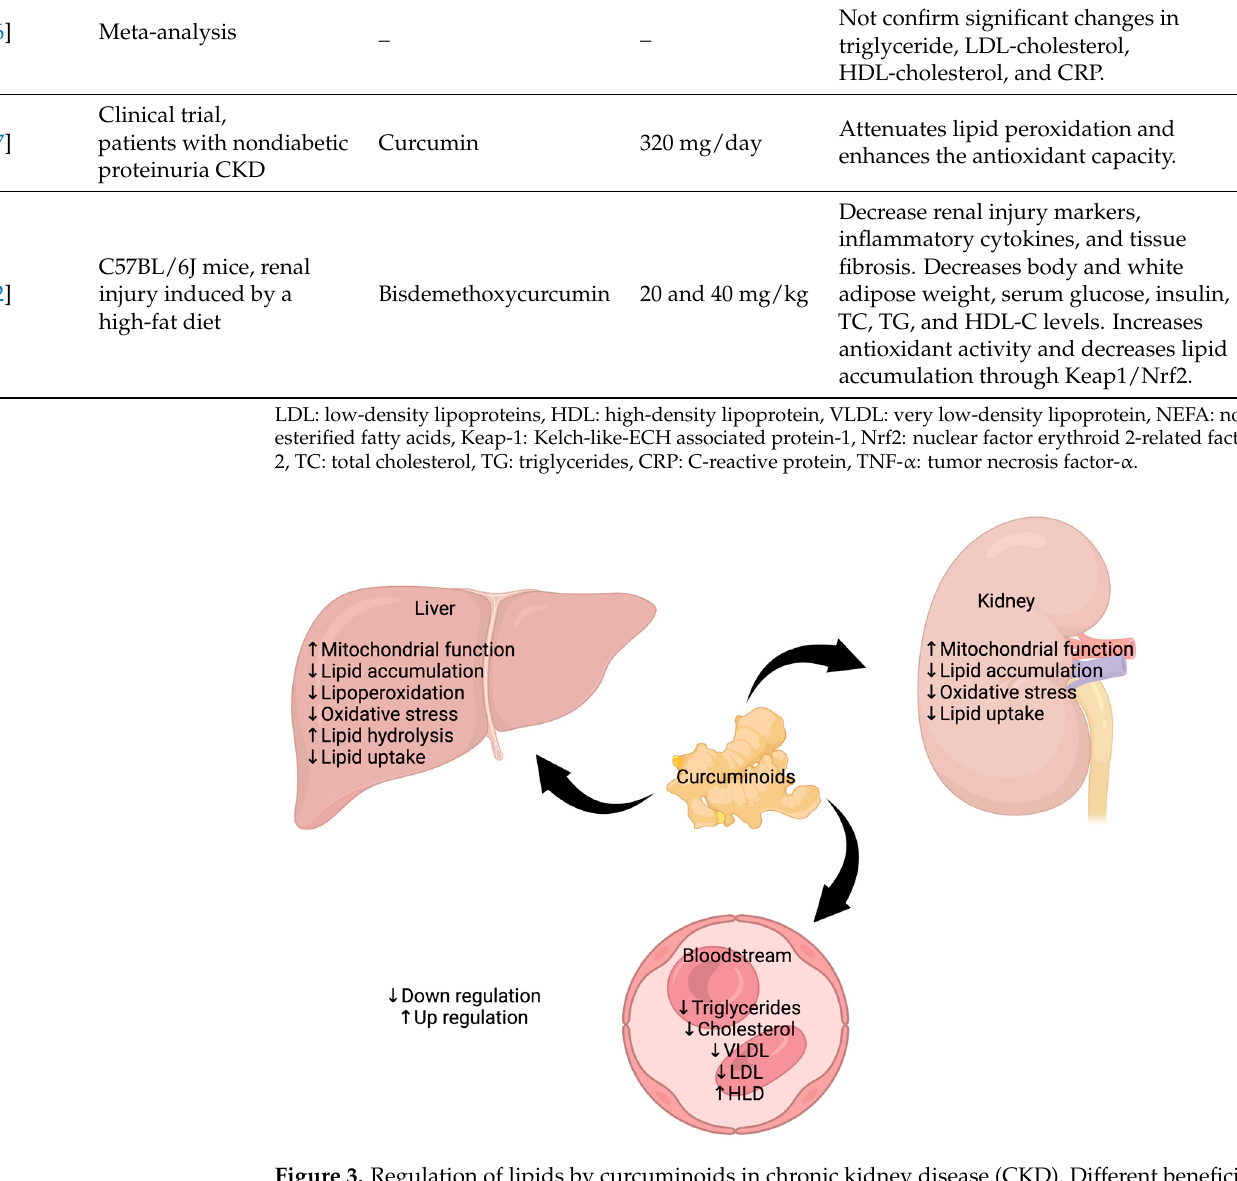
Figure 3. Regulation of lipids by curcuminoids in chronic kidney disease (CKD). Different